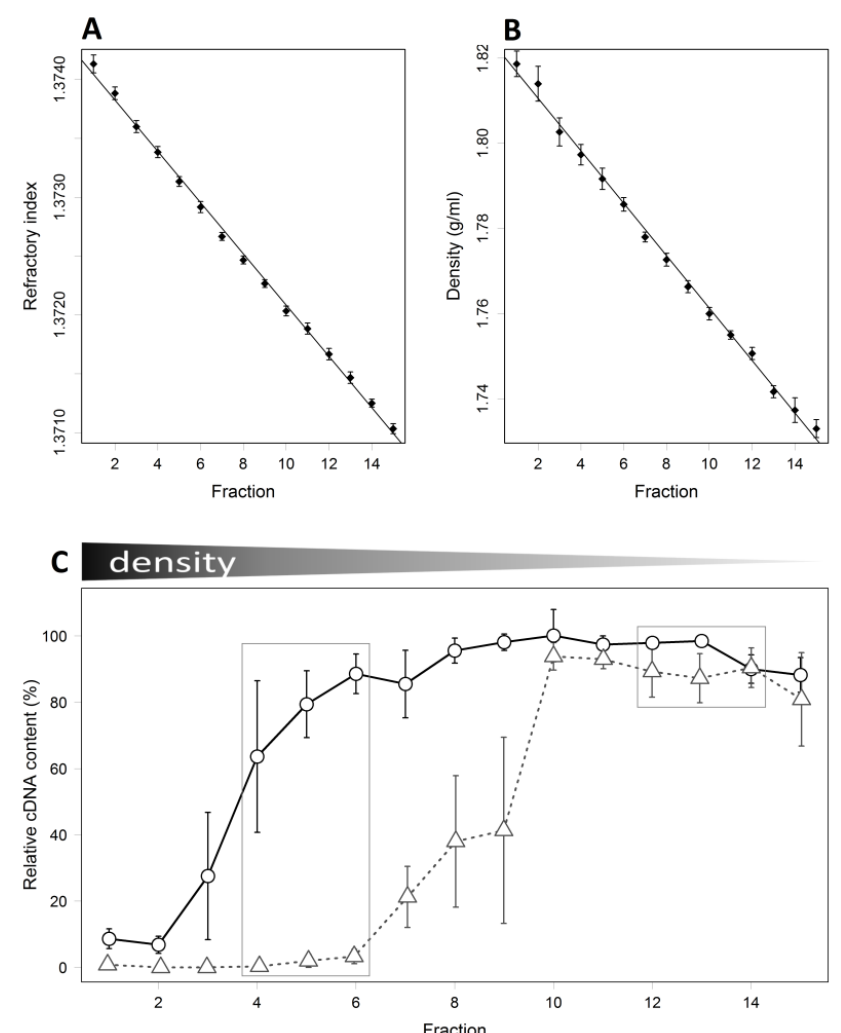
Figure 2. Refractory index ( A ) and buoyant density ( B ) curves from isopycnic buoyant density gradients. Means and standard errors (SEM) of six gradients are shown; ( C ) mean relative content of cDNA ± SEM in fractions collected from density gradients